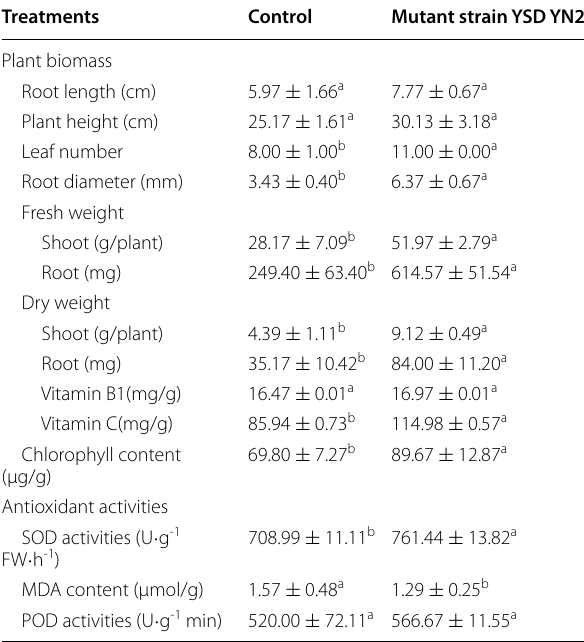
Table 2 Effect of the mutant strain YSD YN2 on plant biomass and antioxidant activities